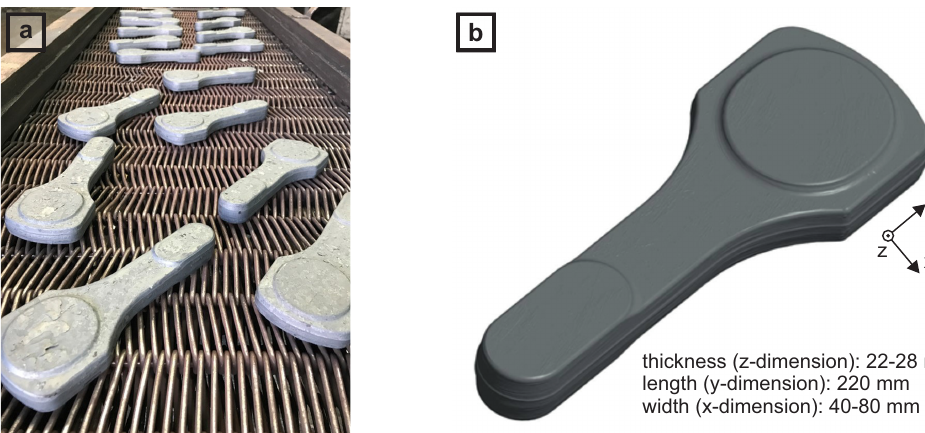
Figure 1. Shape and geometry of the semifinished con-rod. ( a ) Picture of the components after forging at a conveyor belt; ( b ) computer model of the